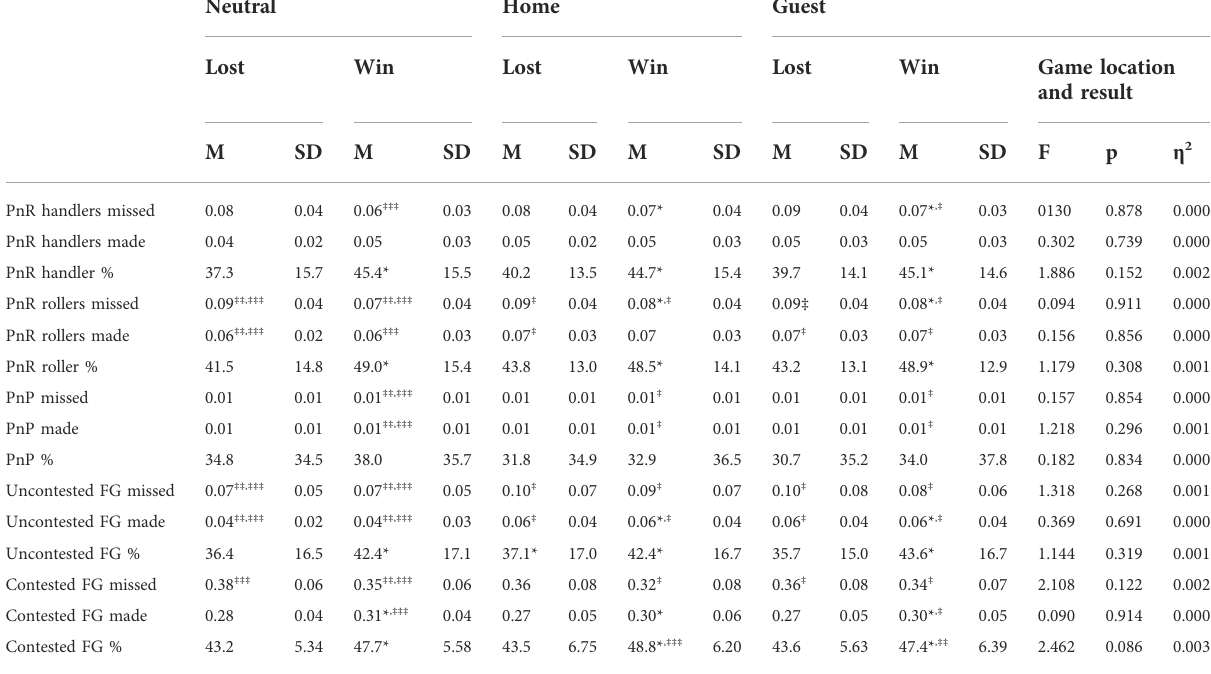
TABLE 4 Results of picks and defensive indicators (per